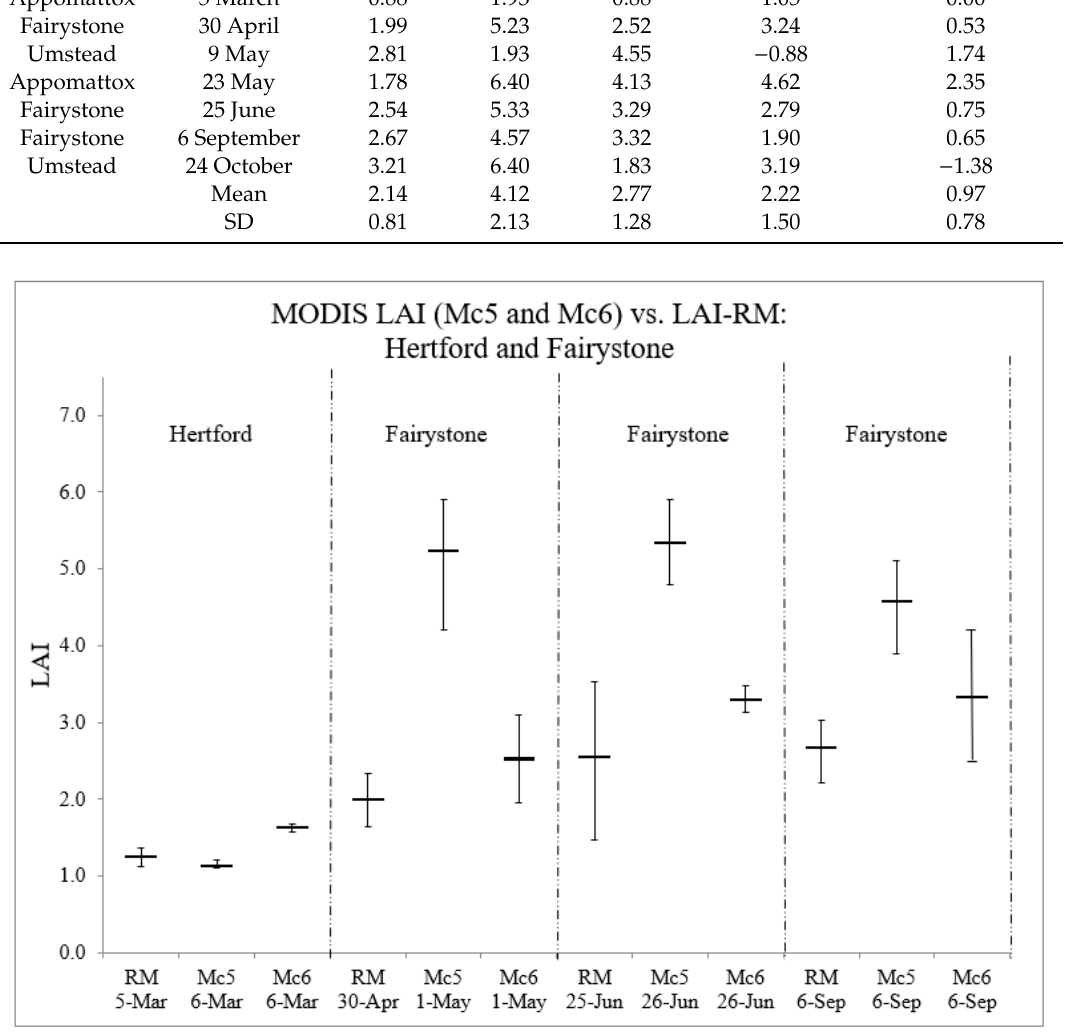
Figure 5. Hertford and Fairystone MODIS LAI (Mc5 and Mc6) comparisons to LAI-RM.